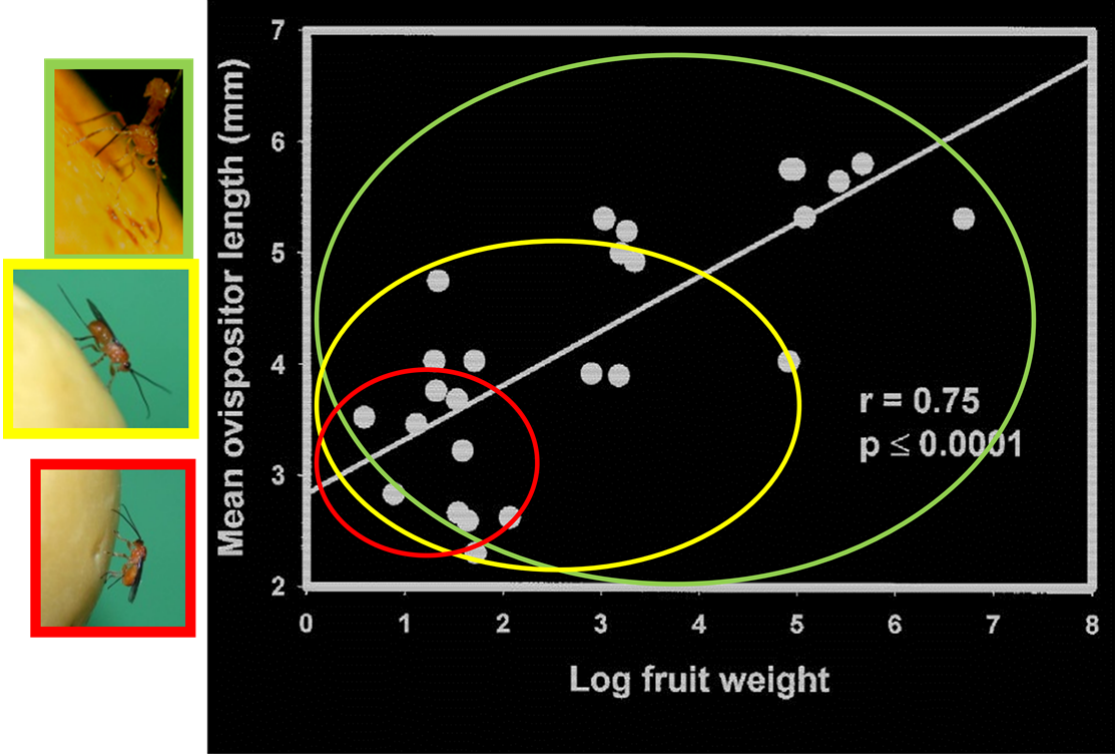
Figure 2. Ovipositor length influences how effectively a female opiine braconid can reach host larvae in various sized fruit, hence the positive relationship between the mean ovipositor lengths of parasitoids recovered from fruit and fruit weight. This is illustrated diagrammatically by the colored circles representing the ranges of fruit sizes accessible to host-foraging parasitoids with descending ovipositor lengths (green = Diachasmimorpha longicaudata , yellow = Doryctobracon areolatus , and red = Utetes anastrephae )